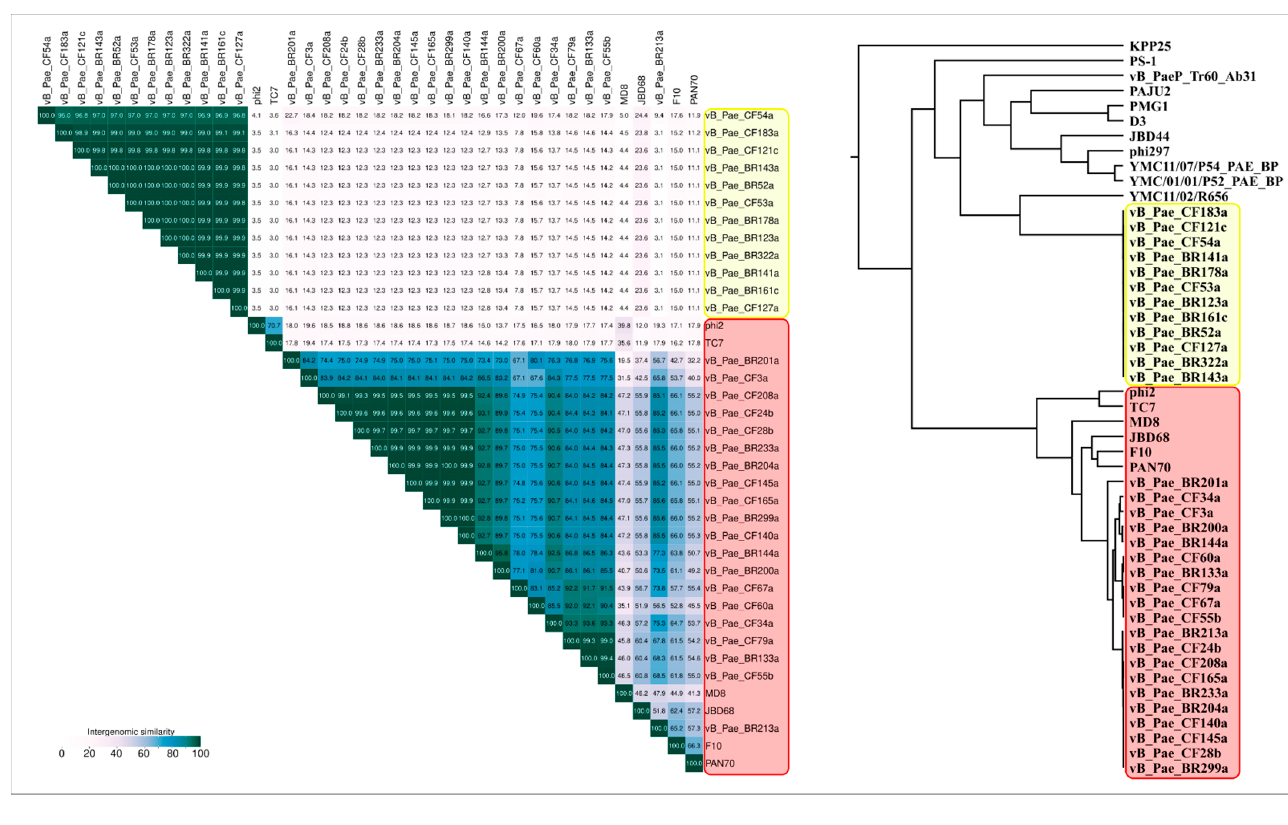
Figure 9. ( a ) Circular proteomic dendrogram plotted by ViPTree using phage genomes of 26 MD8-like phages and genomes found by ViPTree to be related to MD8-like genomes. ( b , c ) The clade of the proteomic tree containing MD8-like phages and phage λ . ( d ) The VIRIDIC matrix (left) and ViP dendrogram using an extended set of Pseudomonas phages.